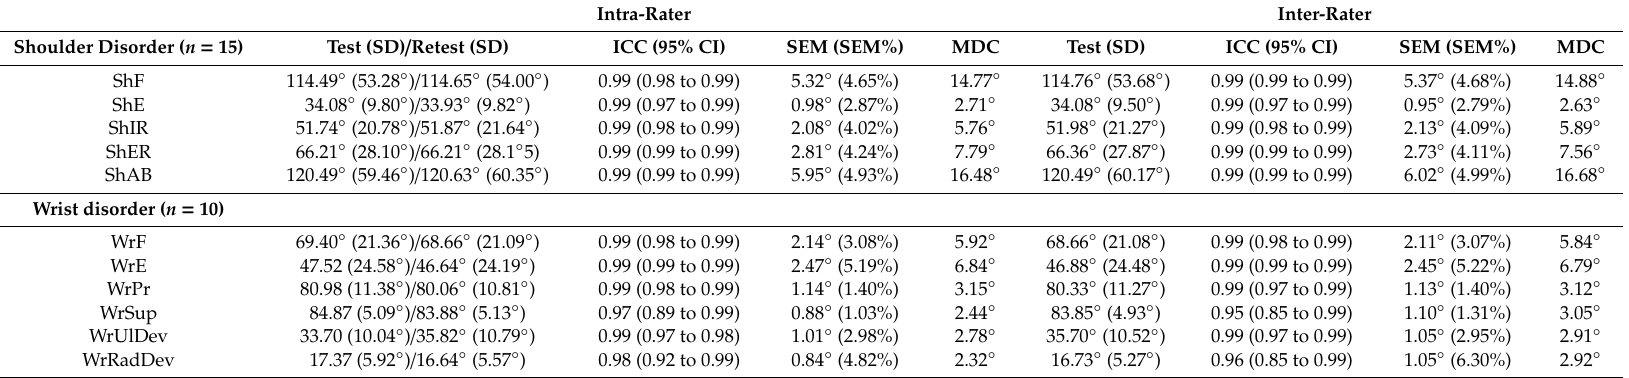
Table 4. Reliability of Veloflex-IDA to measure the range of motion of the upper limb joints in symptomatic